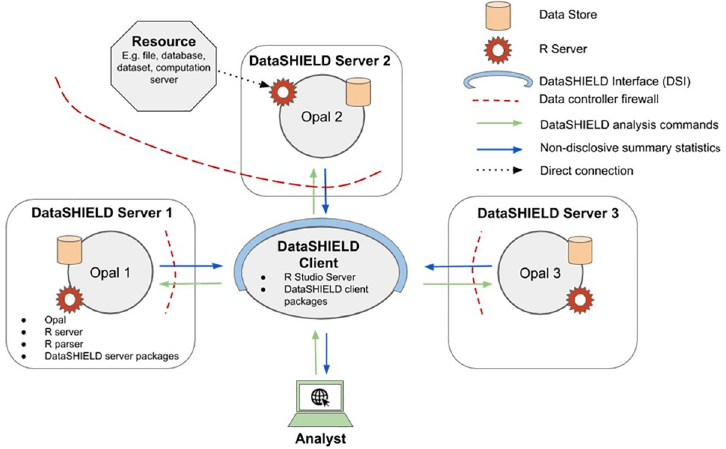
Fig 1. A schematic diagram of a multi-site DataSHIELD infrastructure. It includes one central analysis node (the client) and three data nodes (the servers).